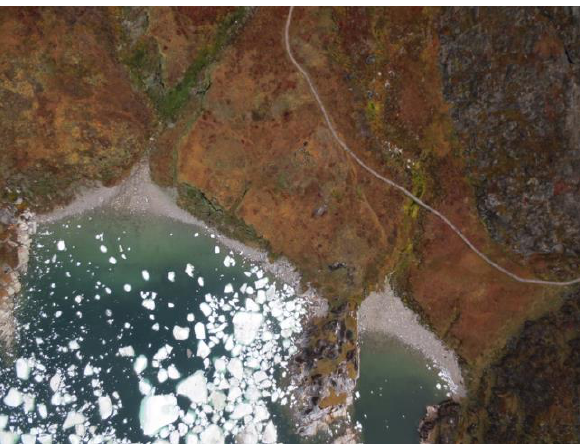
Figure 13. Sermermiut old settlement, (Pavelka, Šedina, 2015)